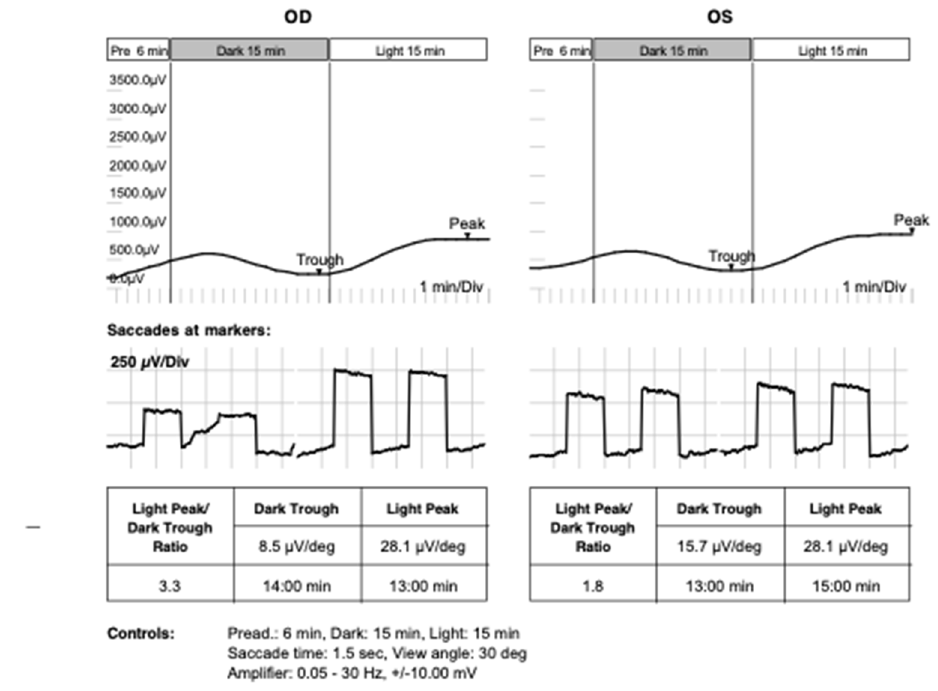
Figure 7. EOG test result in a patient with reticular dystrophy. Near lower limit of normal Arden ratio in the left eye was detected.